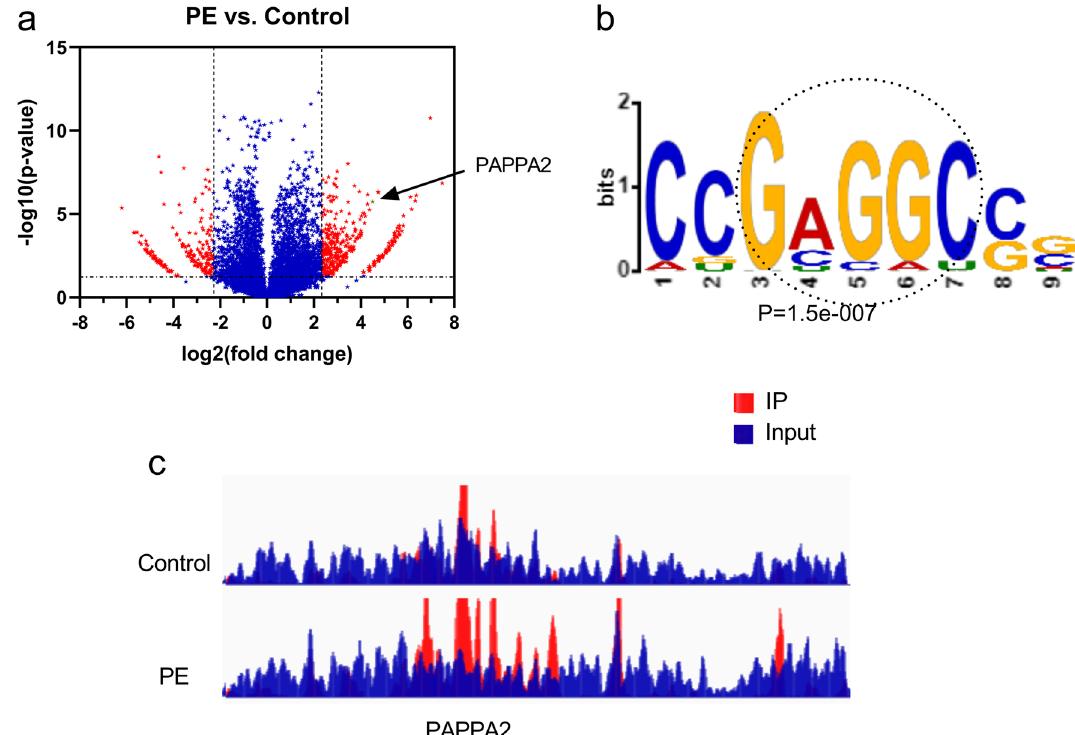
Figure 4. Volcano plots displaying distinct m6A-modified circRNAs and their statistical significance (fold change ≥ 5 and P < 0.05) ( a ). The main consensus motif (GAGGC) was identified in both the control and PE groups by sensitive, thorough, rapid enriched motif elicitation (STREME) of m6A sequencing data ( b ). m6A peaks were enriched in the CDS or 3 ′ UTR of the PAPPA gene according to alignment visualization. The squares mark increases in m6A peaks in PE compared with control samples (IGV software, genome: Homo_sapiens_ HG19) ( c ) (IP: m6A RNA